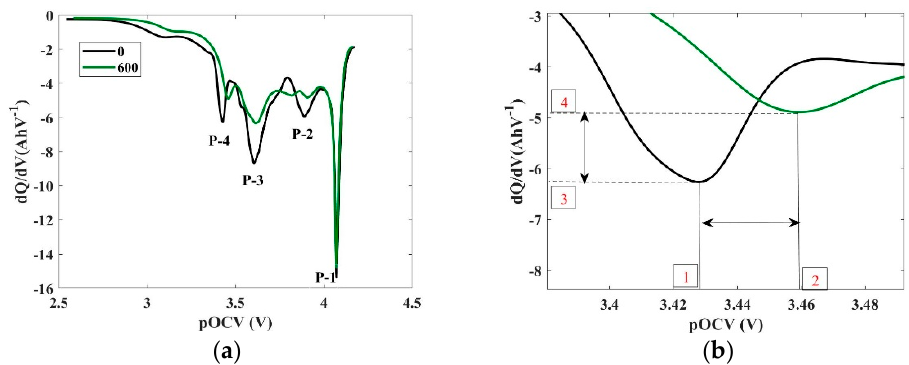
Figure 2. IC curve of a cell ( a ) at new (0 cycle) and aged (600 cycle) condition ( b ) magnified 4th IC peak (P-4). Adapted from [16].